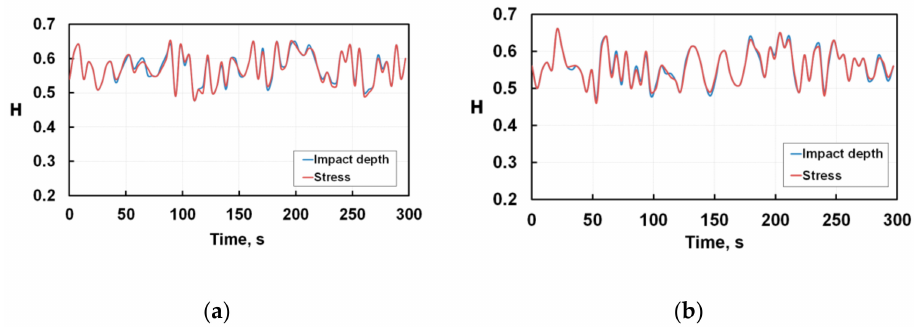
Figure 4. Cyclic variations of Hurst exponents for nanoindentation tests of monolayer ( a ) and multilayer ( b )